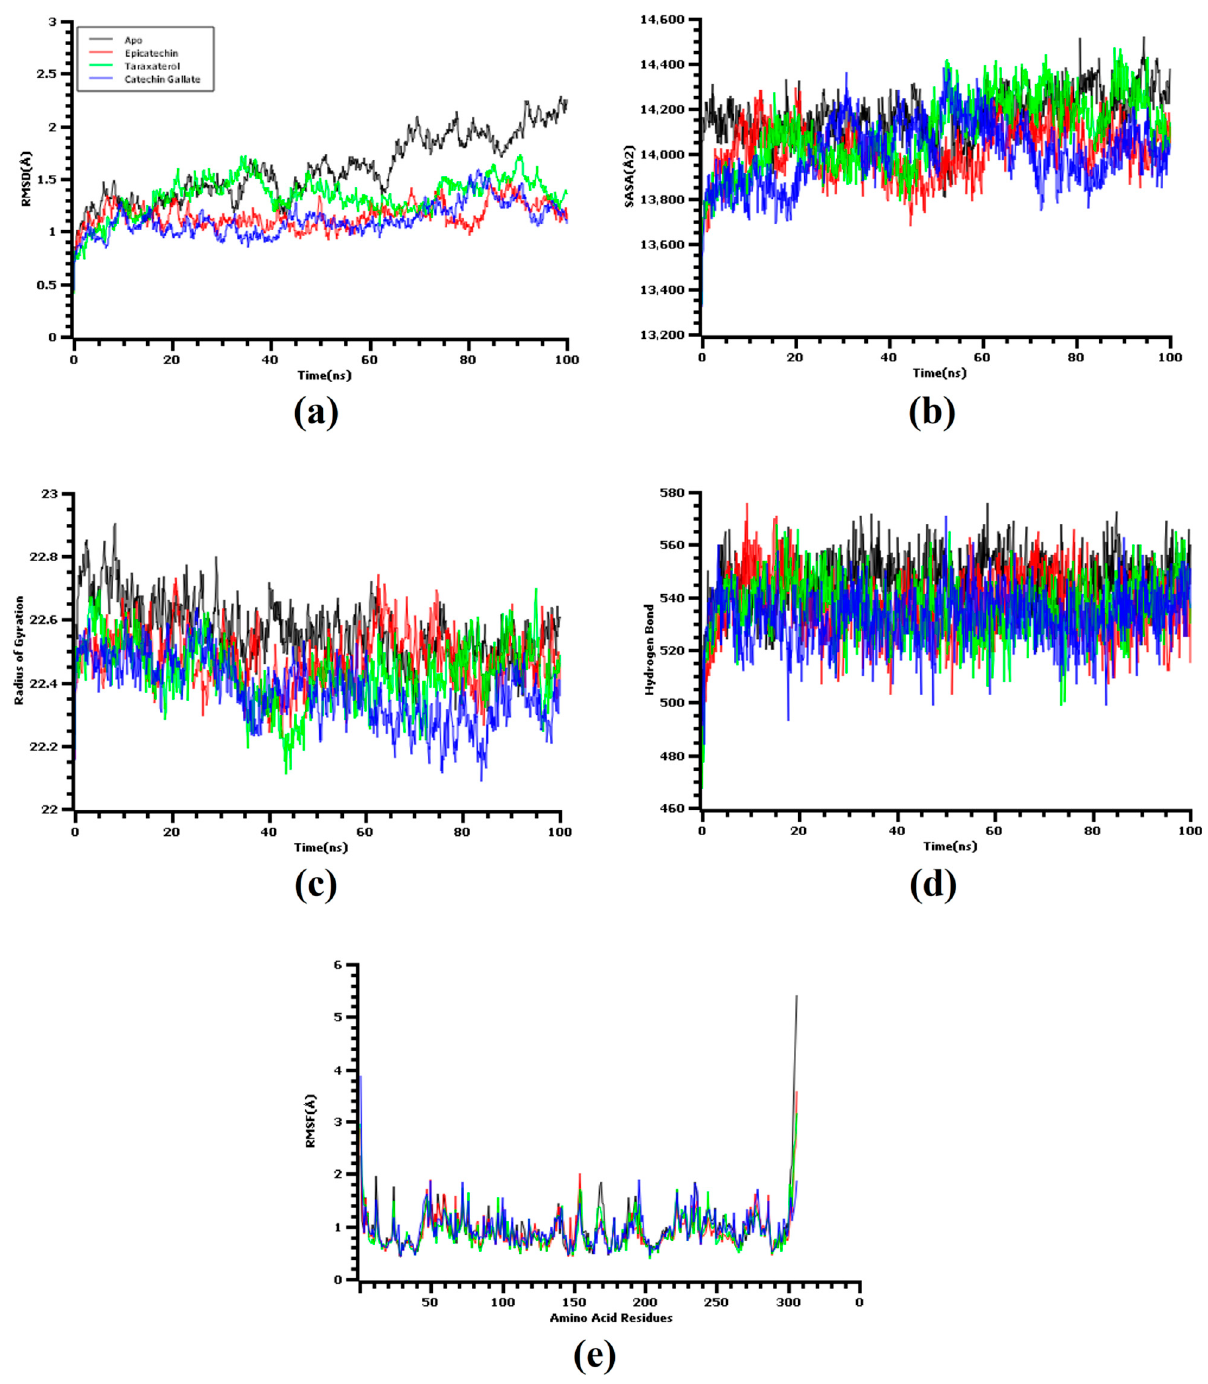
Figure 3. Time series analyses for all three simulated systems. ( a ) RMSD analysis for the alpha carbon atoms, ( b ) protein volume with expansion analysis, ( c ) degree of rigidity and compactness analysis, ( d ) hydrogen bond analysis, and ( e ) flexibility analysis of amino acid residues.